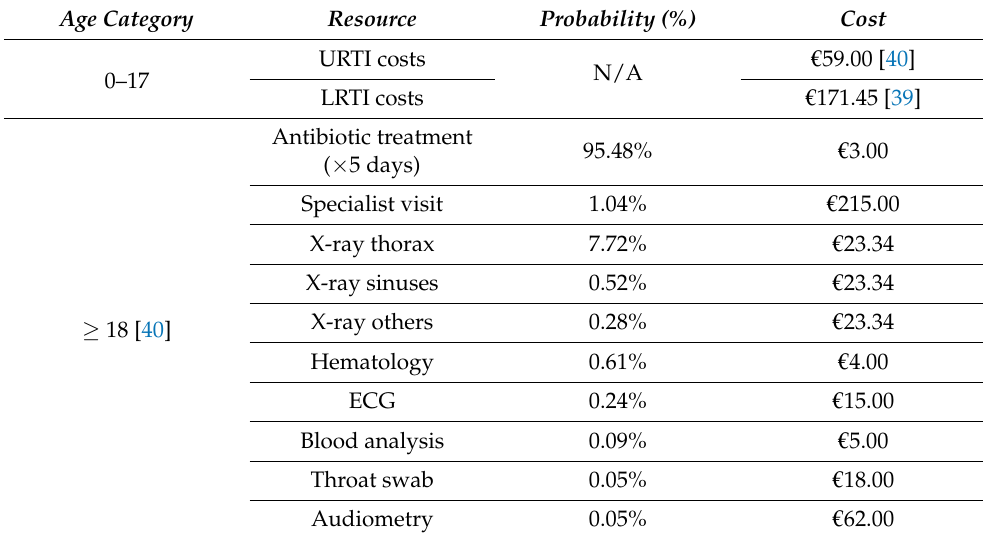
Table 9. Ambulatory complications